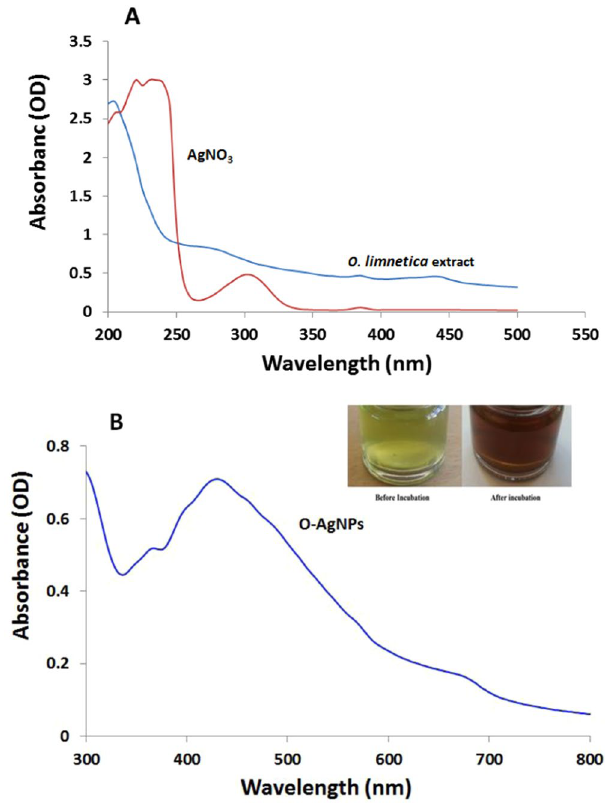
Figure 1. UV-visible absorption spectrum of O. limnetica extract & AgNO 3 ( A ) and silver nanoparticles (O-AgNPs) biofabricated after 48 h of reaction ( B